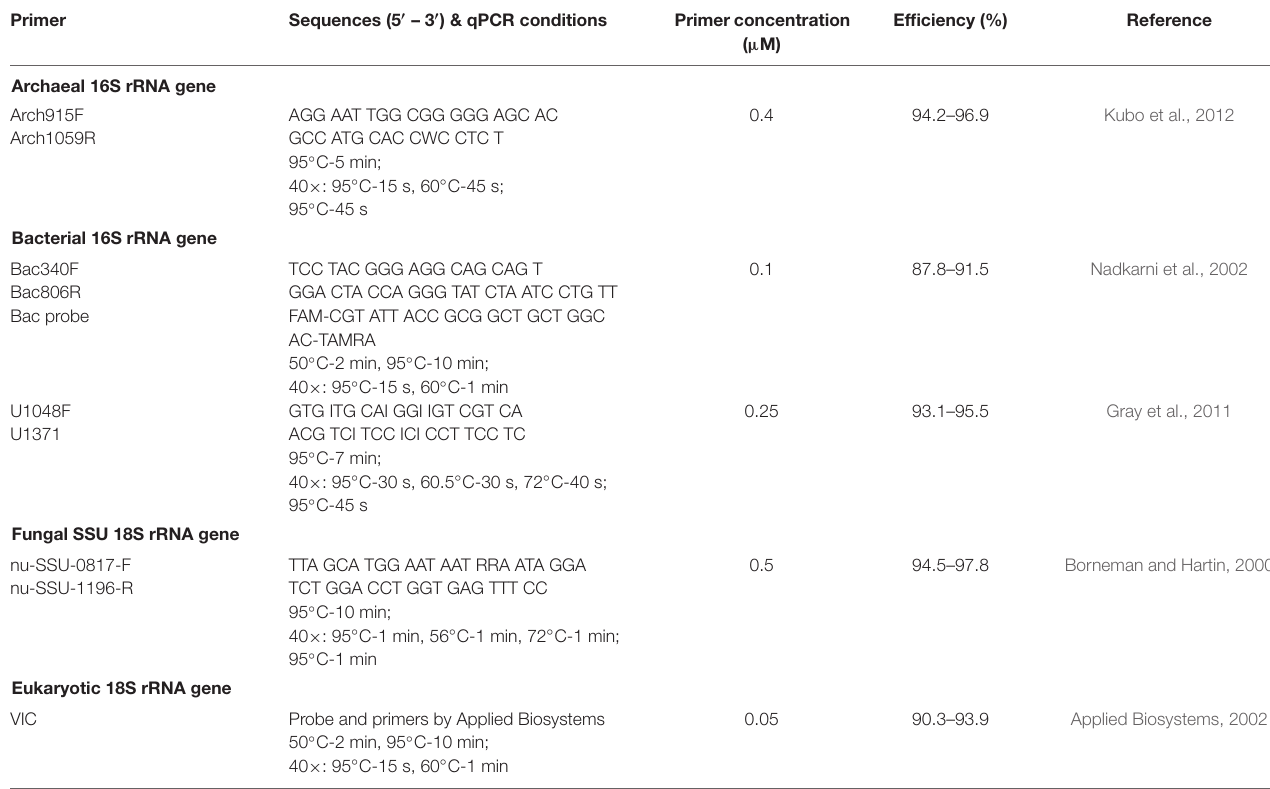
TABLE 1 | Primers and conditions for qPCR